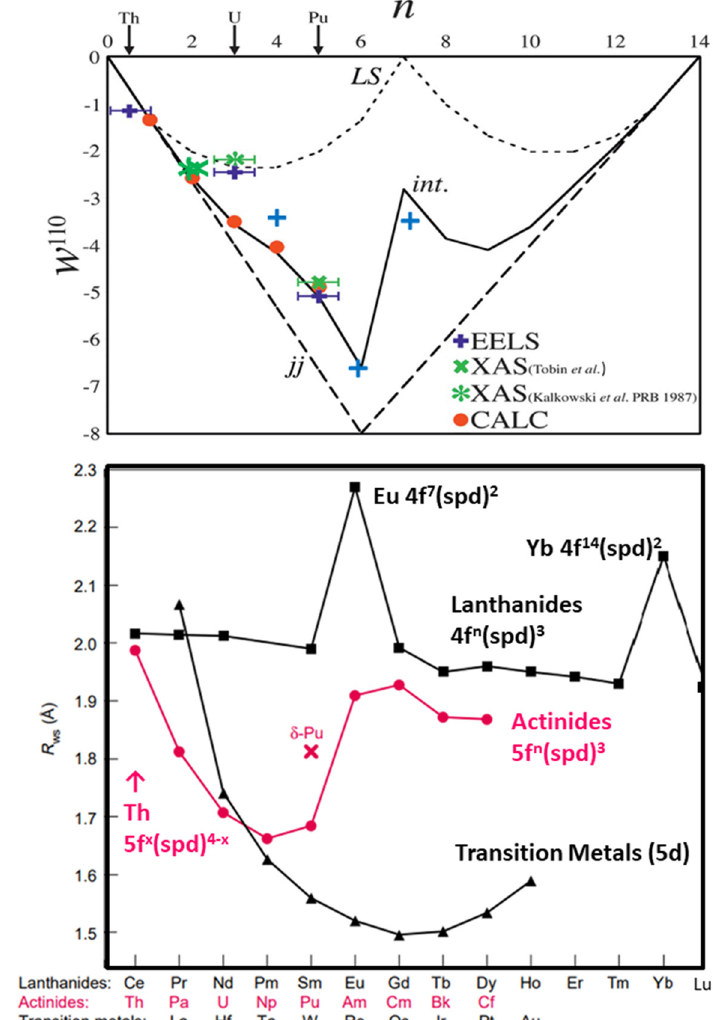
Figure 1. A comparison of the branching ratio results (top panel) and the atomic sizes (lower panel) for a series of actinide samples. Top panel: The spin-orbit operator expectation value, <W 110 >, versus the 5f occupation, n . The top panel is based on Figure 4 of Reference [8], with additional data from [10,11]. The experimental values at n =2 are for UF 4 [12] and UO 2 . The experimental values at n = 4, 6 and 7 are for Np, Am and Cm, respectively. Three theory curves are shown for LS (Russell–Saunders), jj and intermediate coupling. Lower panel: The experimental Wigner Seitz radii for the lanthanides, actinides and 5d series are shown here. “The Wigner-Seitz radius RWS (the radius of the volume per atom in a solid) is defined as (4 π /3)RWS 3 = V, where V is the equilibrium volume of the primitive unit cell. The atoms of the actinides, lanthanides, and transition metals are aligned so that elements that lie on top of each other have the same number of valence electrons.” Taken from Reference [3] with permission [13]. Unless otherwise indicated, this information has